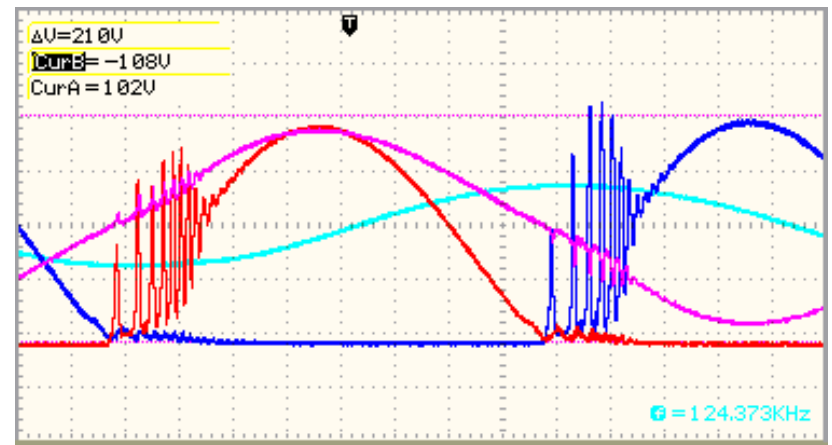
Figure 14. Oscillations due to PCB layout issues.